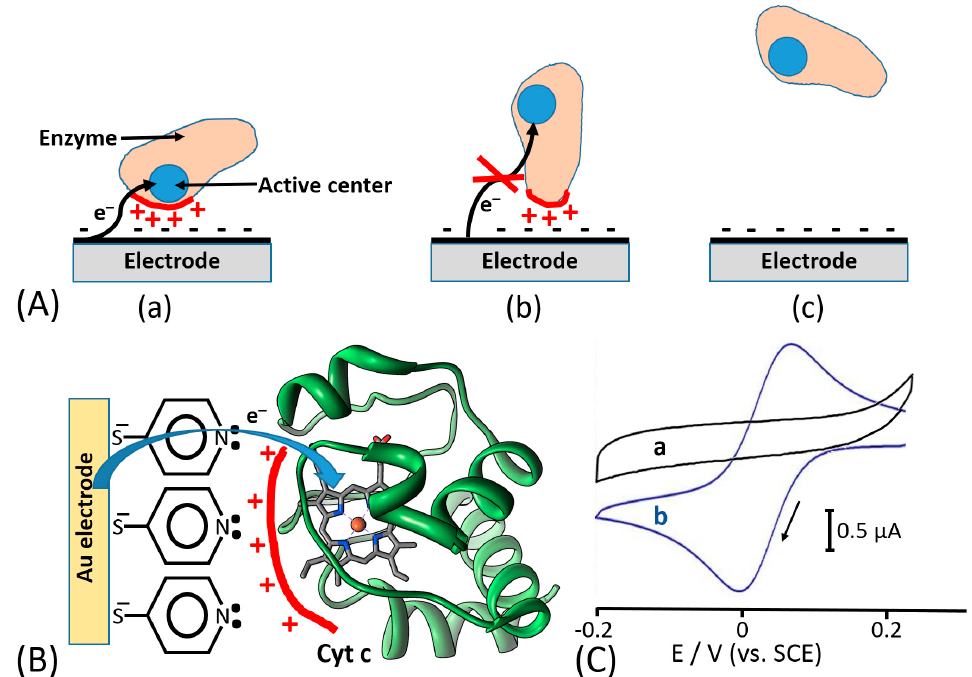
Figure 5. ( A ) Non-specific protein adsorption outcomes: (a) Electrostatic attraction of oppositely charged protein residues and electrode surface results in immobilization of the protein in an electroactive orientation, facilitating direct electron transfer between a redox center and the